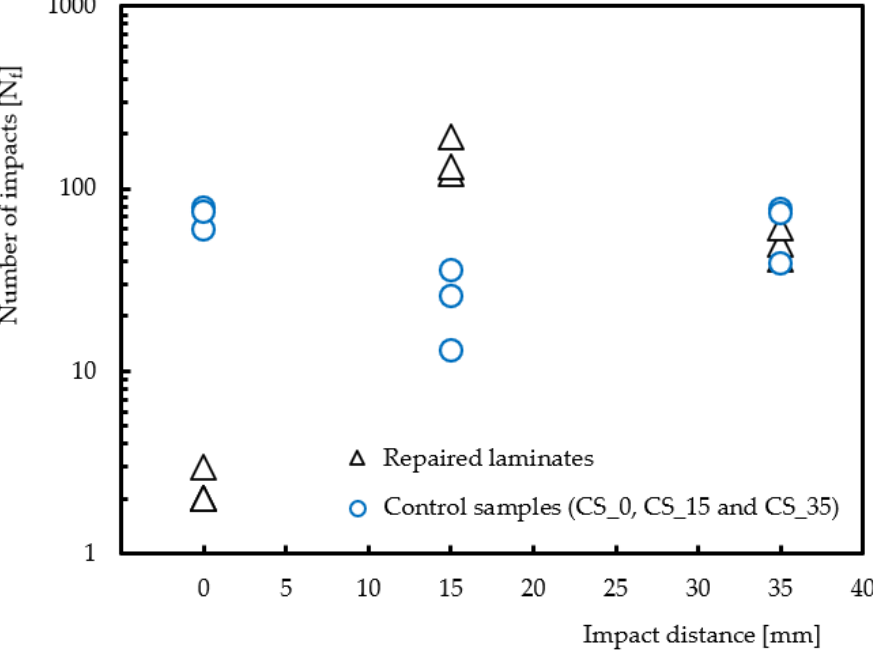
Figure 4. Distance effect on the number of impacts to rupture.